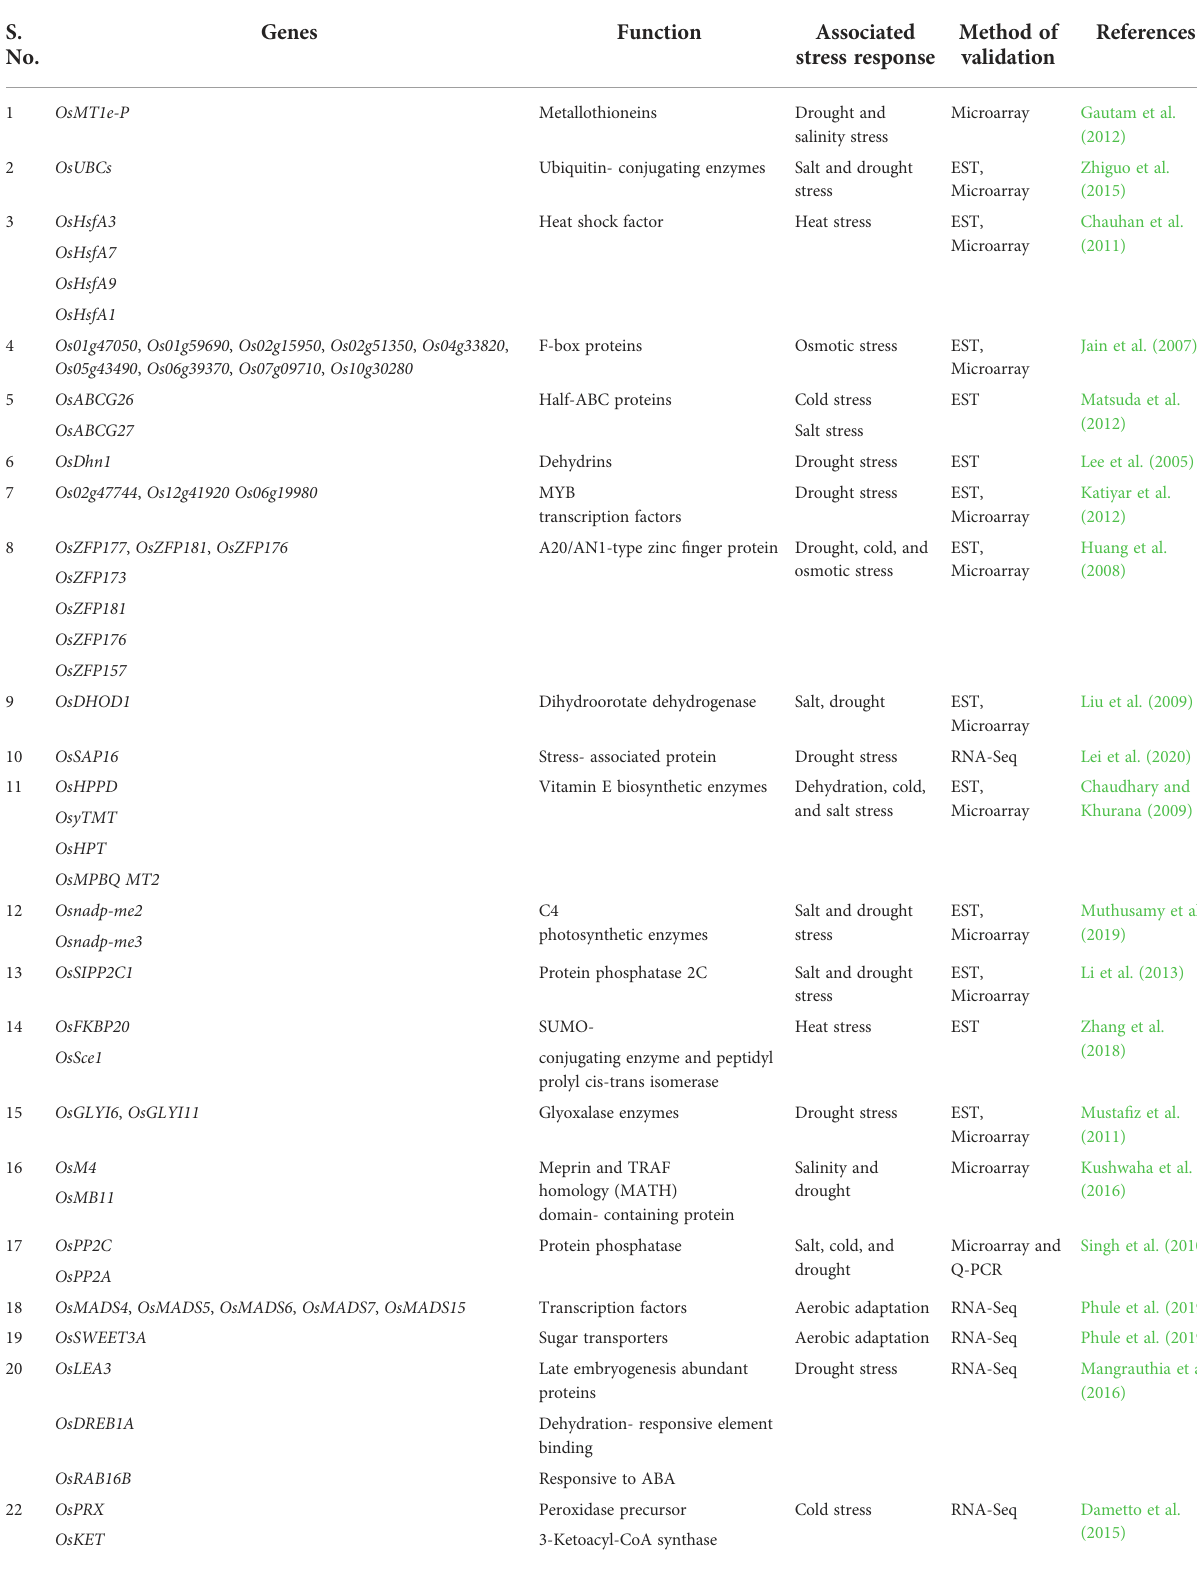
TABLE 2 Summary of abiotic stress-responsive genes in rice identi fi ed using transcriptomic approaches. S.